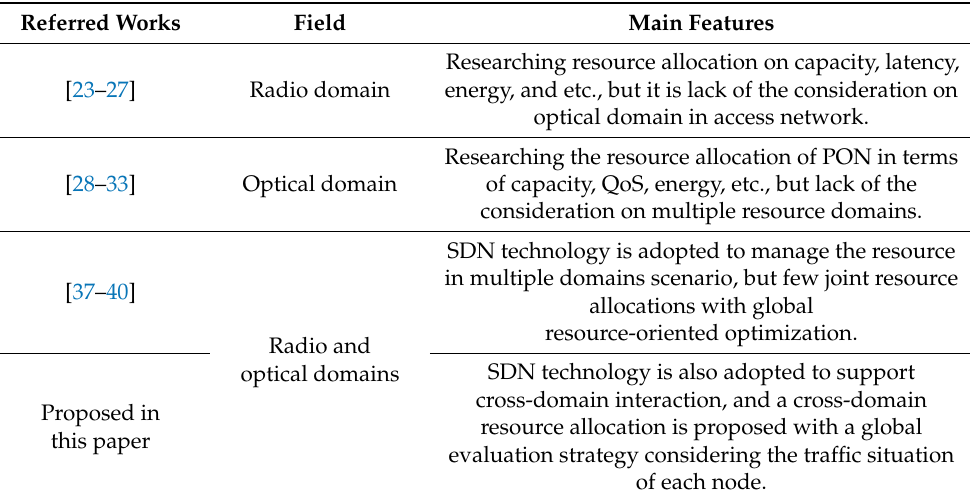
Table 1. Main feature summary of existing works compared with the proposed